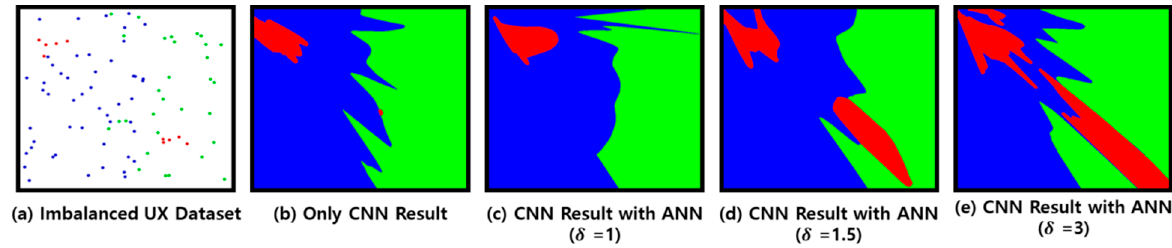
Figure 5. CNN results of imbalanced dataset.